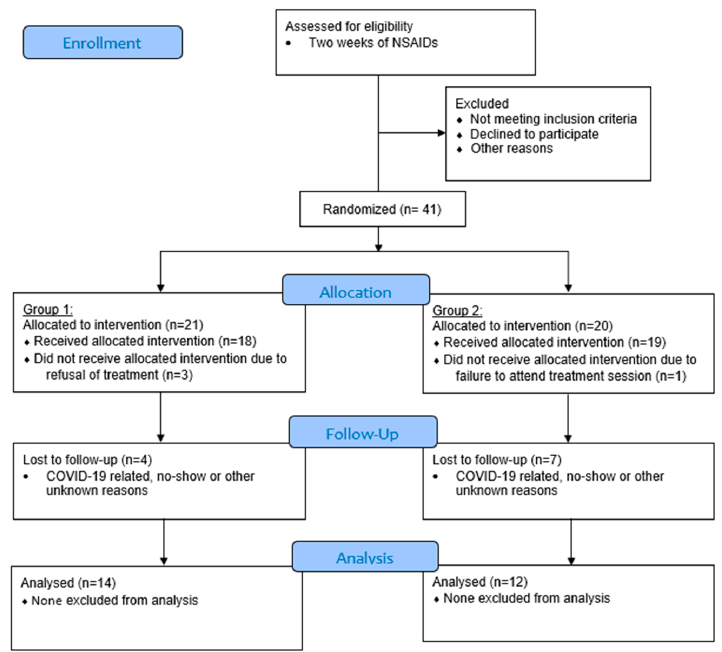
Figure 1. CONSORT flow diagram (version 2010) of subject enrolment, allocation, and follow-up. Group 1: extracorporeal shockwave therapy (ESWT); Group 2: placebo.